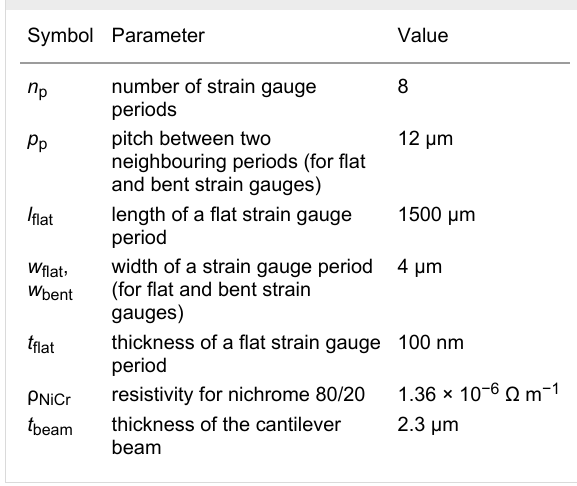
Table 2: Symbols, parameters and values used for the physical model of the antiparallel artificial hair